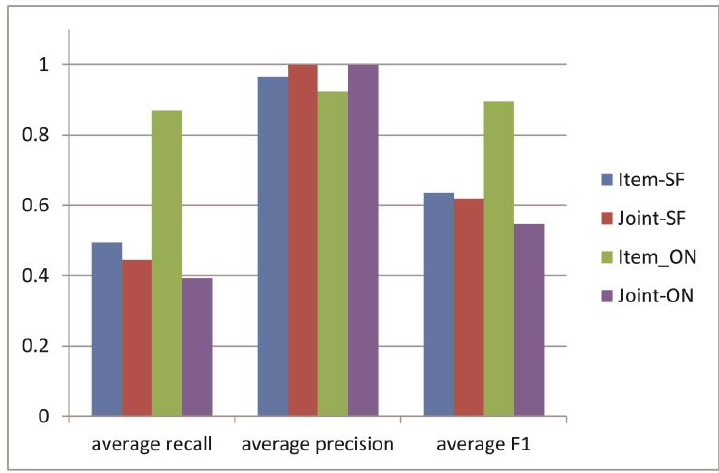
Figure 7. Average recall, precision, and F1 when the similarity threshold is equal to 0.15.